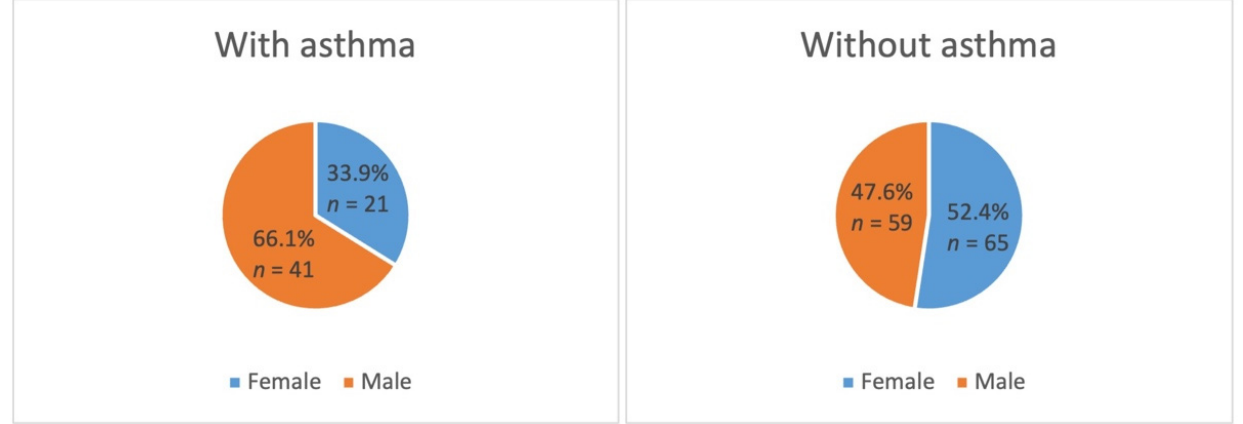
Figure 1. Distribution of the sample by